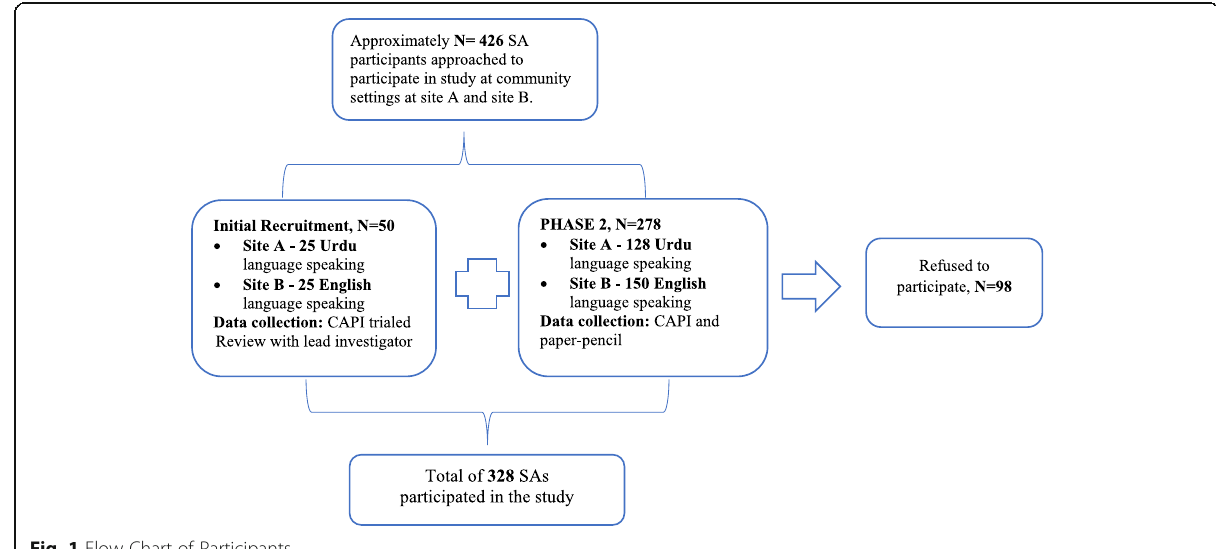
Fig. 1 Flow Chart of